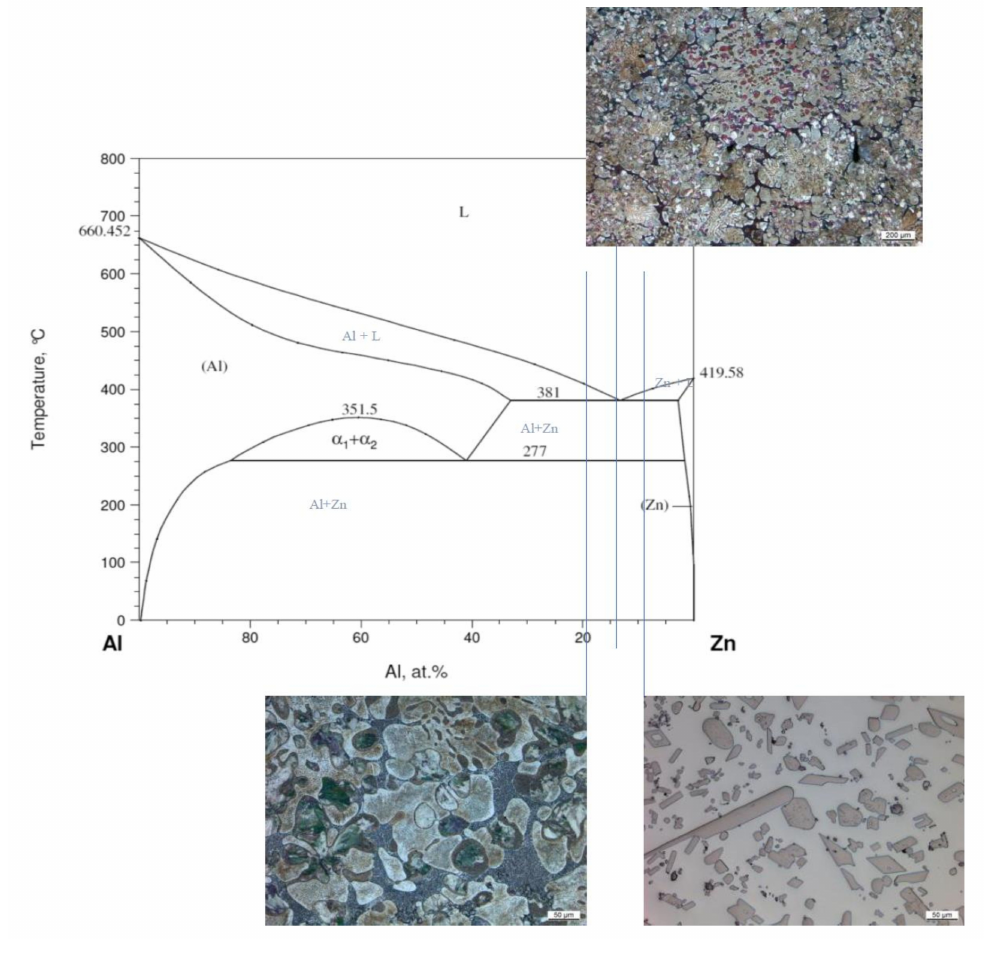
Figure 2. Al-Zn phase diagram [10].